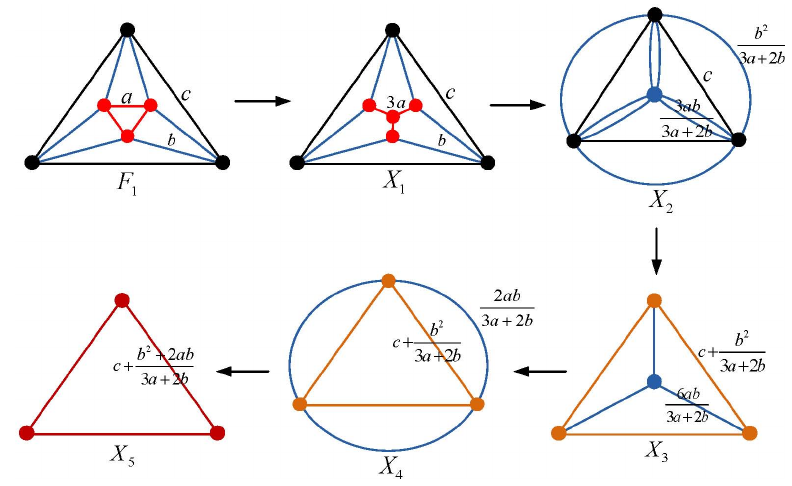
Fig. 4. The transformations from F 1 to X 5 .